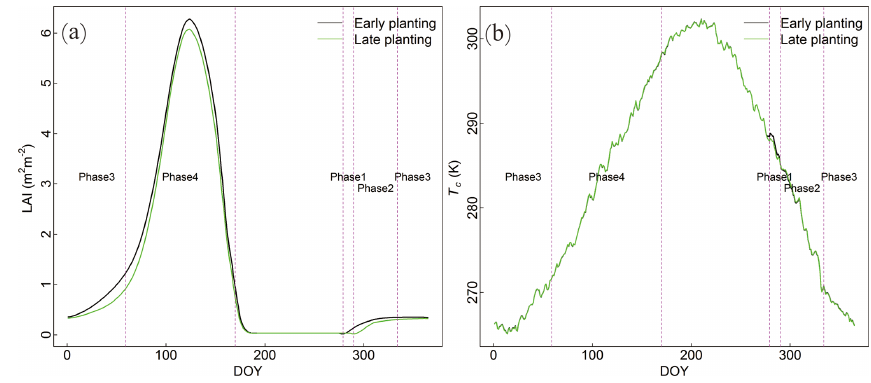
Figure 2. Dynamics of (a) LAI and (b) T c under two sowing scenarios in the winter wheat growing season.